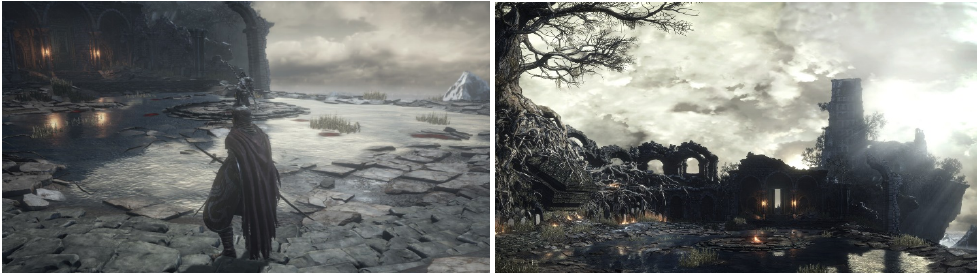
Figure 4. Mission main battle